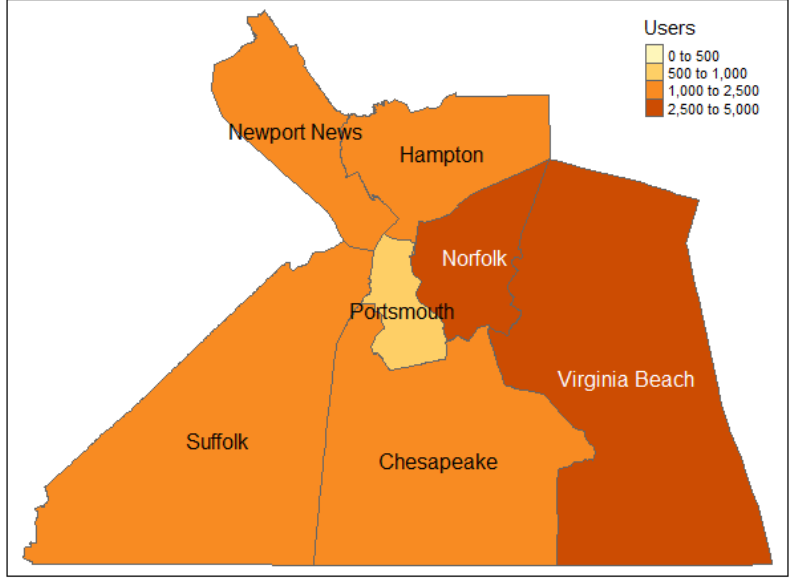
Figure 1. Distribution of Twitter users by city.